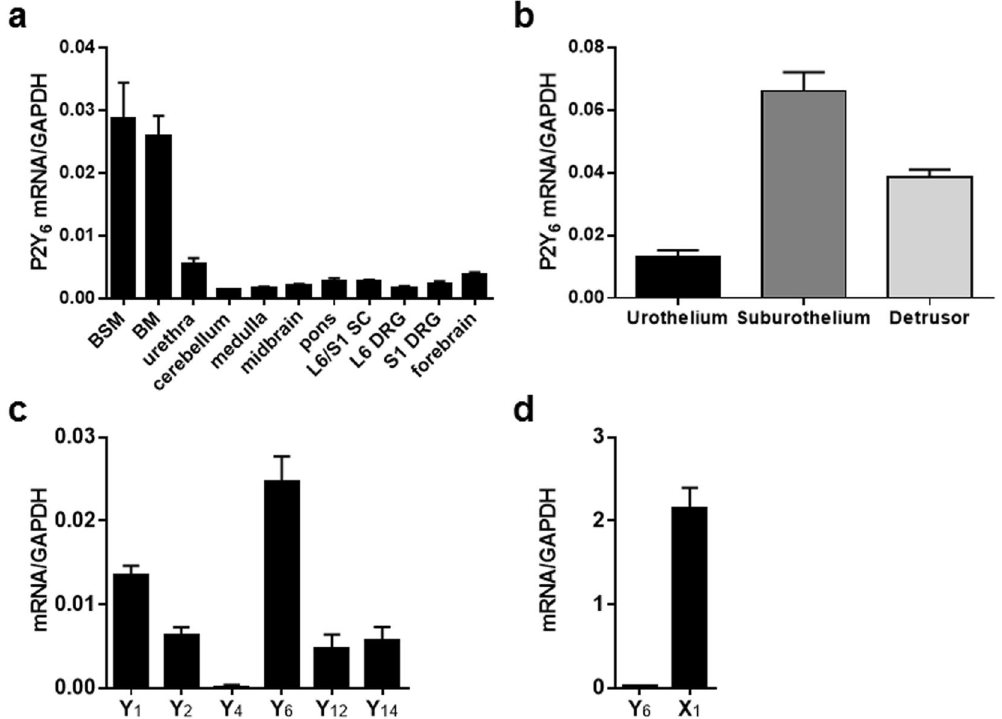
Figure 1. P2Y 6 mRNA expression in the WT mouse. ( a ) Quantitative real-time RT-PCR analysis of P2Y 6 mRNA expression in tissues associated with the control of lower urinary tract activity (n = 5). Glyceraldehyde- 3-phosphate dehydrogenase (GAPDH) was used as a reference gene. BSM, bladder smooth muscle; BM, bladder mucosa; SC, spinal cord; DRG, dorsal root ganglion. ( b ) P2Y 6 mRNA expression in urothelium, suburothelium, and detrusor (n = 7). ( c , d ) Gene expression of P2Y subtypes (n = 10) and P2X 1 (n = 10). Data are presented as the mean ±